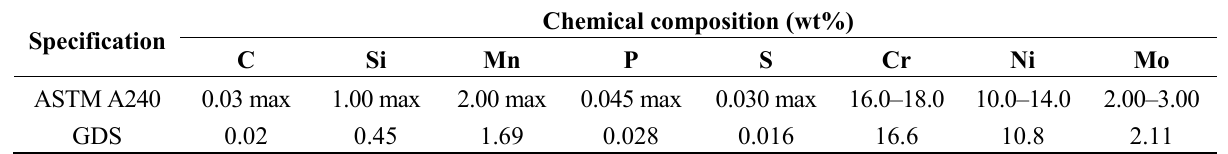
Table 1. Chemical composition of UNS S31603 stainless steel (wt%, balance